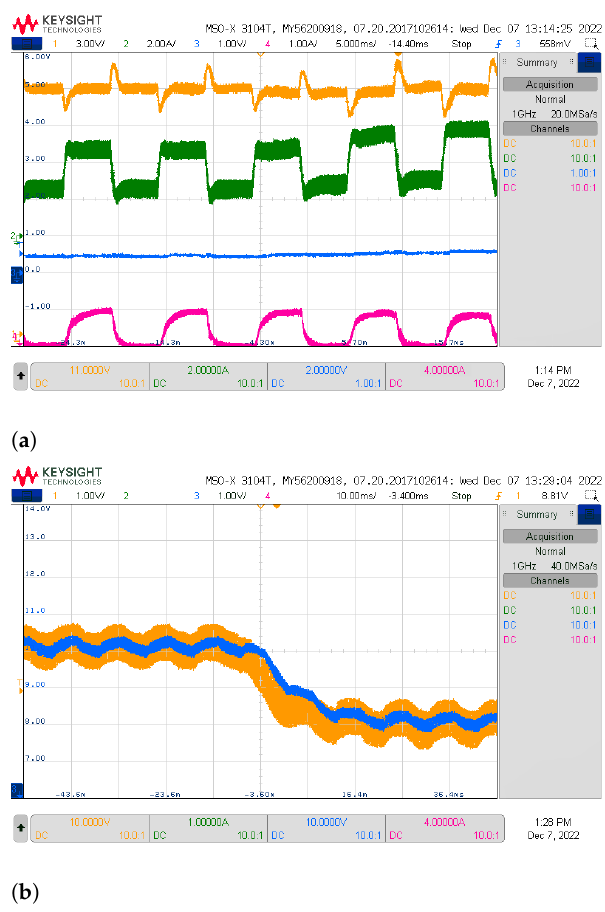
Figure 9. Dynamical response of the proposed controller when the input voltage varies from 10 to 8 V. ( a ) Experimental results for the boost converter when the DC load is a 100 Hz square waveform that varies between 1 and 2 A , with a duty cycle of 0.5. CH1: x 2 (3 V/div), CH2: x 1 (2 A/div), CH3: u (1/div), CH4: ˆ i DC (1 A/div), and time base of 5ms. ( b ) Input voltage changes from 10 V to 8 V. CH1: (1 V/div), CH3: (1 V/div), and time base of